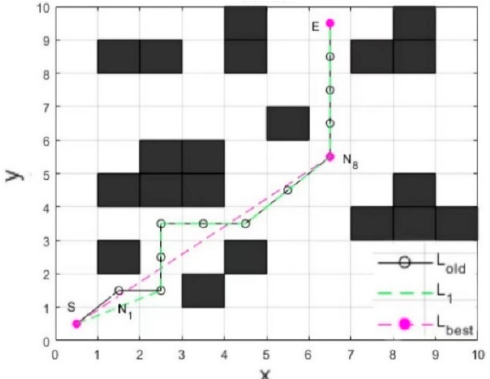
Figure 5. The initial trajectory and the trajectory optimized by mutual learning.